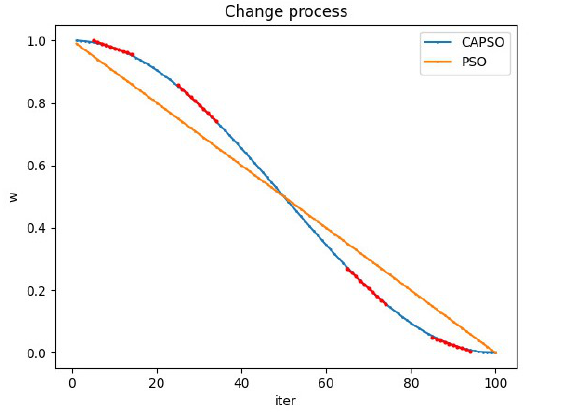
Figure 2. Variation curve of parameter w with the number of